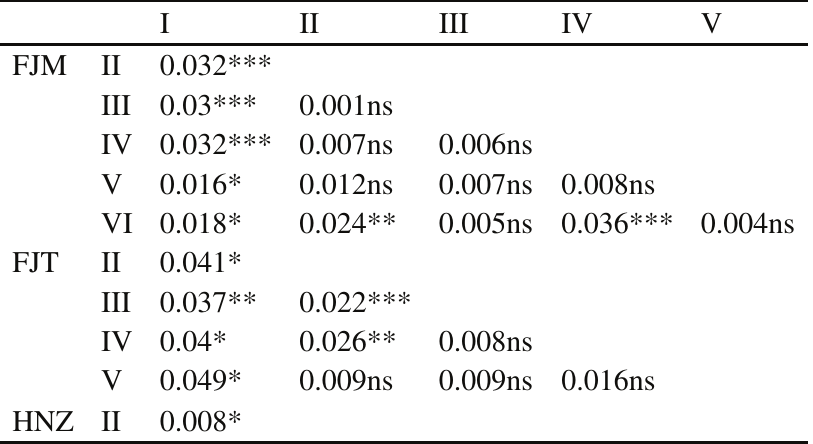
Table S3 Genetic differentiation ( F infinite alleles